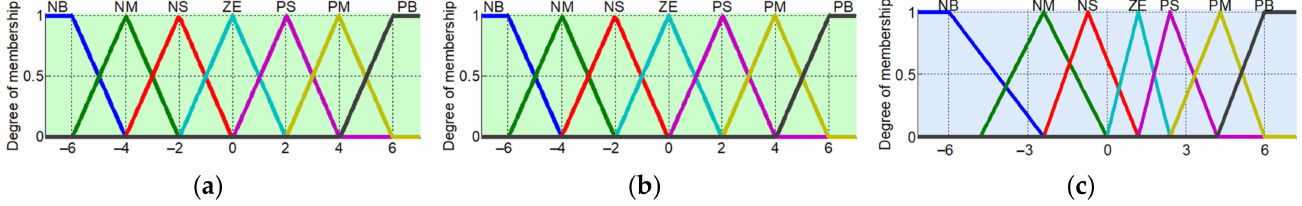
Figure 10. Membership function curve of fuzzy controller: ( a ) change in angle signal ∆ δ t ; ( b ) change